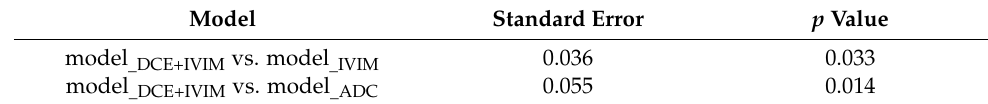
Table 5. Models with significant difference in ROC curves after the Delong test.